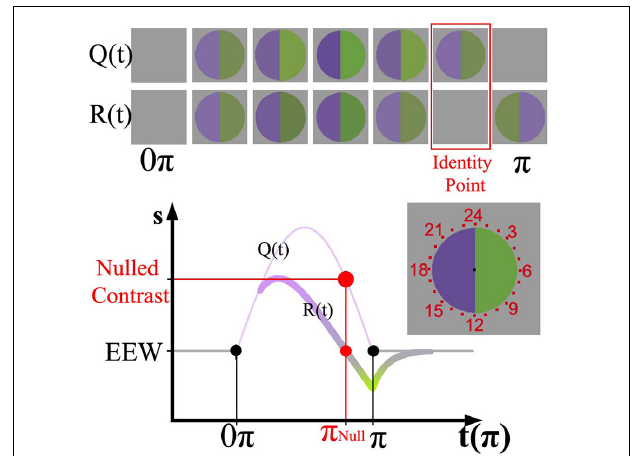
FIGURE 1 | (Top) representation of Zaidi’s paradigm [Q(t)] and the perceptual response over time [R(t)]. (Bottom) sinusoid intensities modulated in the violet hemifield and physiological response curve for RGCs painted according to the perceptual response. The relative amplitude of the sinusoid with respect to the baseline determines the instantaneous contrast of the stimulus. The nulling or identity point is highlighted in red in both representations. The stimulus was surrounded by evenly spaced numbers from 1 to 24 (at the right of the Cartesian representation); in the graph just a set of those numbers is